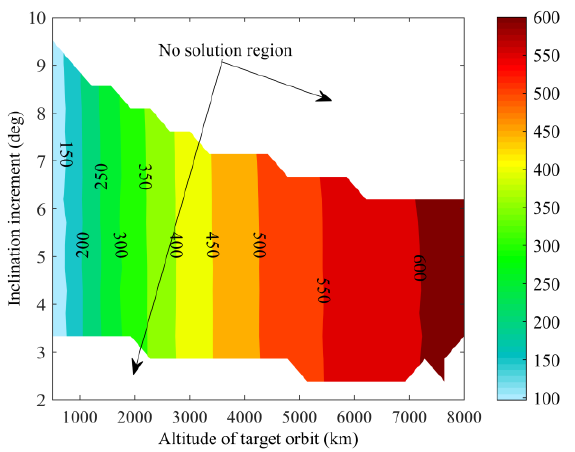
Figure 17. Minimum insertion impulse (unit: m/s) with different altitudes and inclination increments in terms of the target orbit.